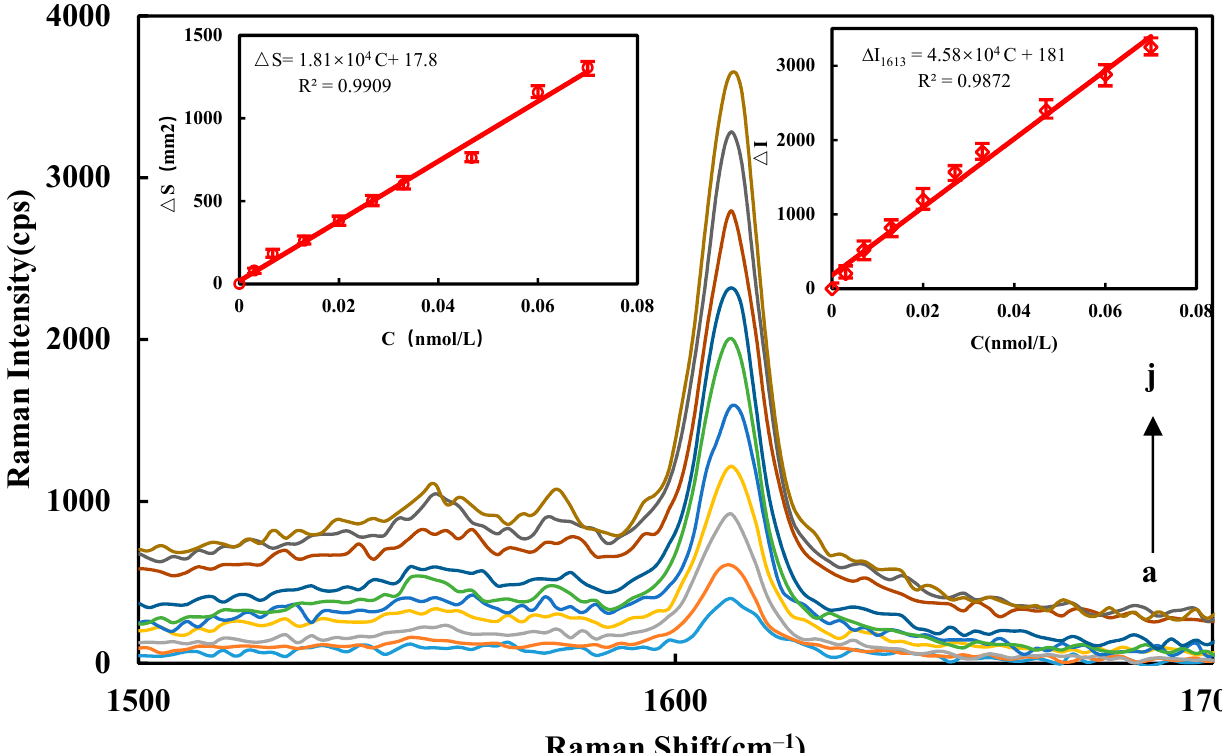
Figure A4. The relationship between SERS intensity and area with OTC concentration. The DdBd-PEG600-HCl-HAuCl4- Apt OTC -OTC-VBB catalytic analysis system: 0.080 g/L HAuCl4 + 0.230 mmol/L HCl + 2.00 g/L PEG600 + 0.450 mmol/L DdBd + 6.70 pmol/L AptOTC + 0.625 μ mol/L VBB+OTC (a–j: 0, 3.00 × 10 − 3 , 6.70 × 10 − 3 , 1.30 × 10 − 2 , 2.00 × 10 − 2 , 2.70 × 10 − 2 , 3.30 × 10 − 2 , 4.70 × 10 − 2 , 6.00 × 10 − 2 , 7.00 × 10 − 2 nmol/L OTC).